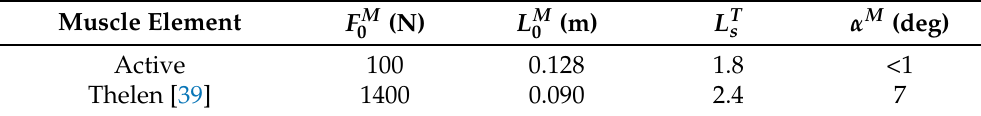
Table 1. Muscle element specific parameters used for simulation. Muscle